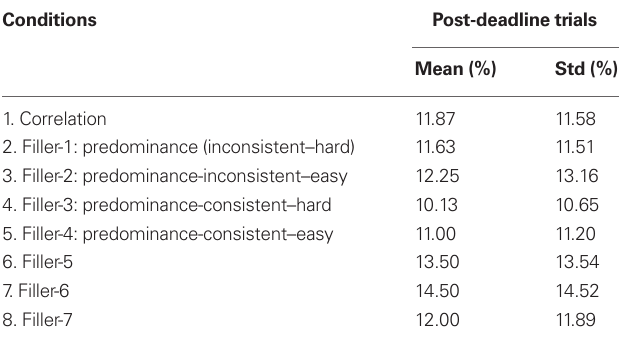
Table A2 | Average percentage of post-deadline